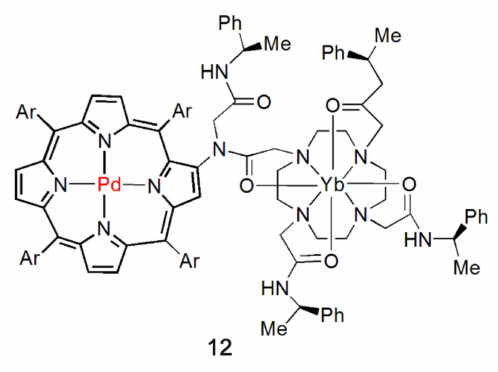
Figure 4. Structure of complex 12 . “Ar” is an abbreviation for “Aryl”. Adapted from ref. [40]. Rusakova et al. reported the polydentate ligands by coupling mono-4-aminotetraphe- nylporphyrin with the anhydride of the ethylenediaminetetraacetic acid (EDTA) or the di- ethylenetriaminepentaacetic acid (DTPA) and constructed NIR radiative metal